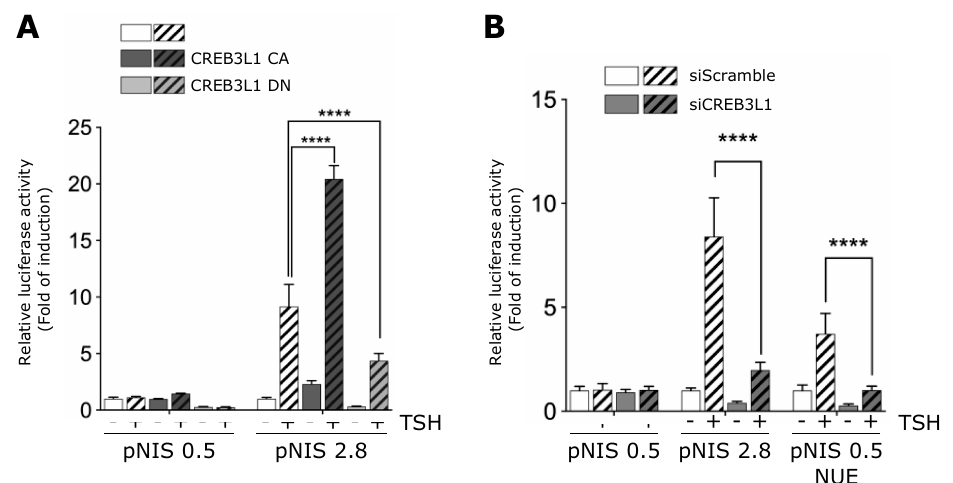
Figure 6. CREB3L1-dependent TSH-induced NIS promoter activity. ( A ) FRTL-5 cells transiently transfected with NIS promoter constructs pNIS 2.8, pNIS 0.5 and co-transfected with either pEGFP (control), a plasmid expressing an active version of CREB3L1 (CREB3L1 CA), or a plasmid expressing a dominant negative version of CREB3L1 (CREB3L1 DN) for 12 h. ( B ) FRTL-5 cells transiently transfected with NIS promoter constructs pNIS 2.8, pNIS 0.5, or pNIS 0.5 NUE and co-tranfected with either siScramble or si CREB3L1 for 12 h. ( A , B ) The cells were then deprived of TSH for 72 h ( − ) and then stimulated with TSH for 8 h (+). The results are expressed as luciferase activity normalized to β -galactosidase and relative to the basal activity for each construct. Bar graphs represent the means ± SEM of three independent experiments performed in triplicates (**** p < 0.0001).